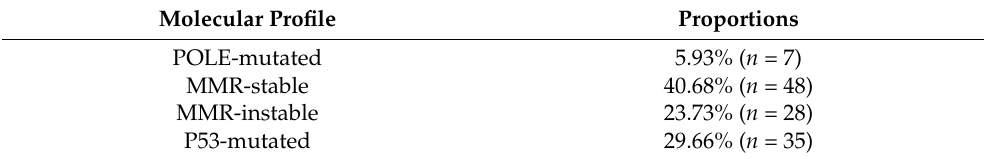
Table 3. Molecular profile distribution.